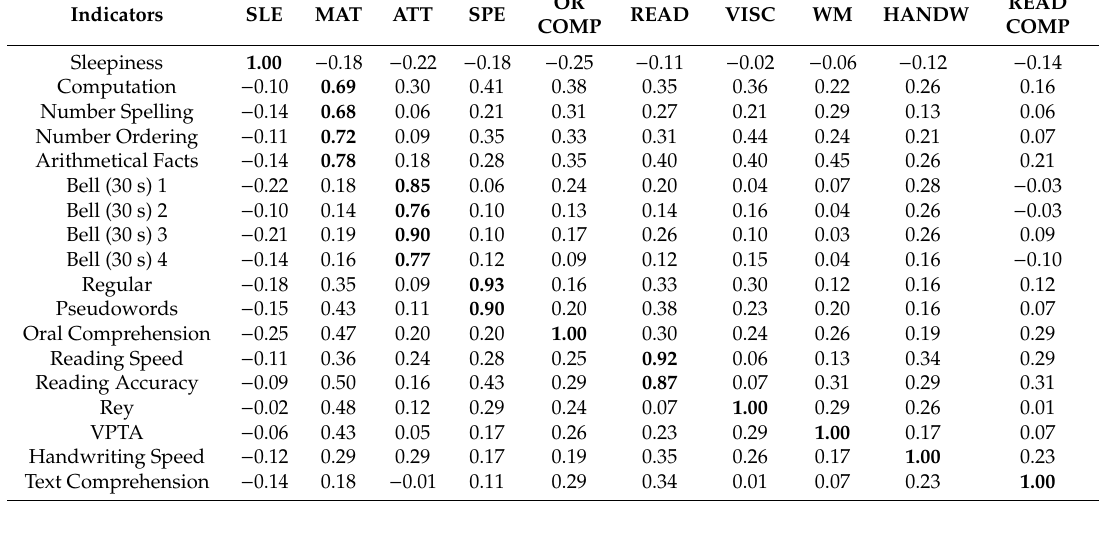
Table 4. Cross-loadings of the indicators. Indicators of each latent variable were reported in bold.